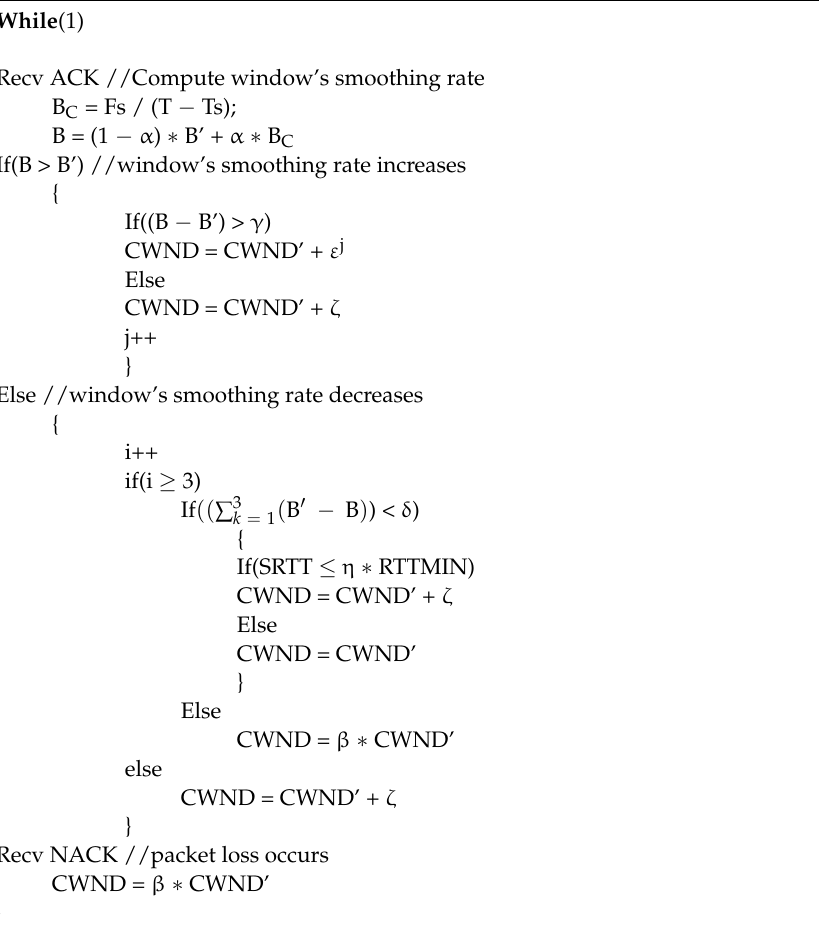
Algorithm A1. Pseudo-Code of Congestion Control